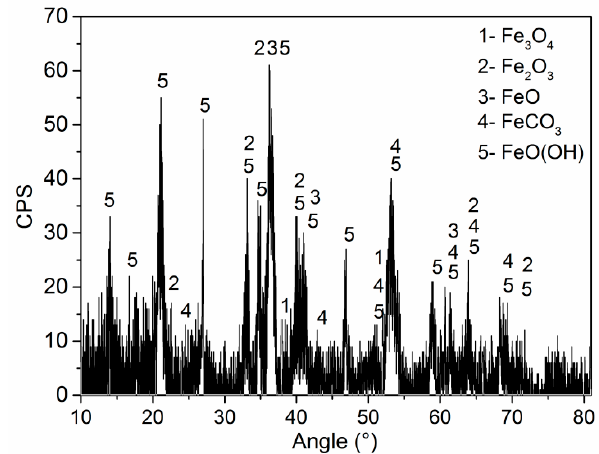
Figure 9. XRD spectra of corrosion products.